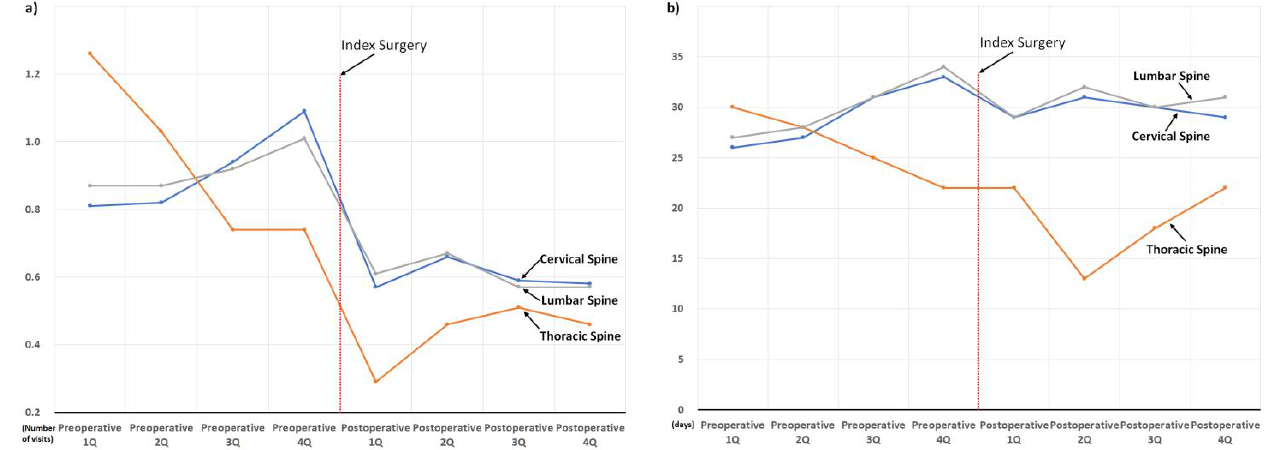
Figure 6. Perioperative changes in the use of sleep medication and hospital visits owing to sleep disorder according to the spinal regions: ( a ) changes in the number of hospital visits, and ( b ) changes in the prescribed duration of sleep medication.